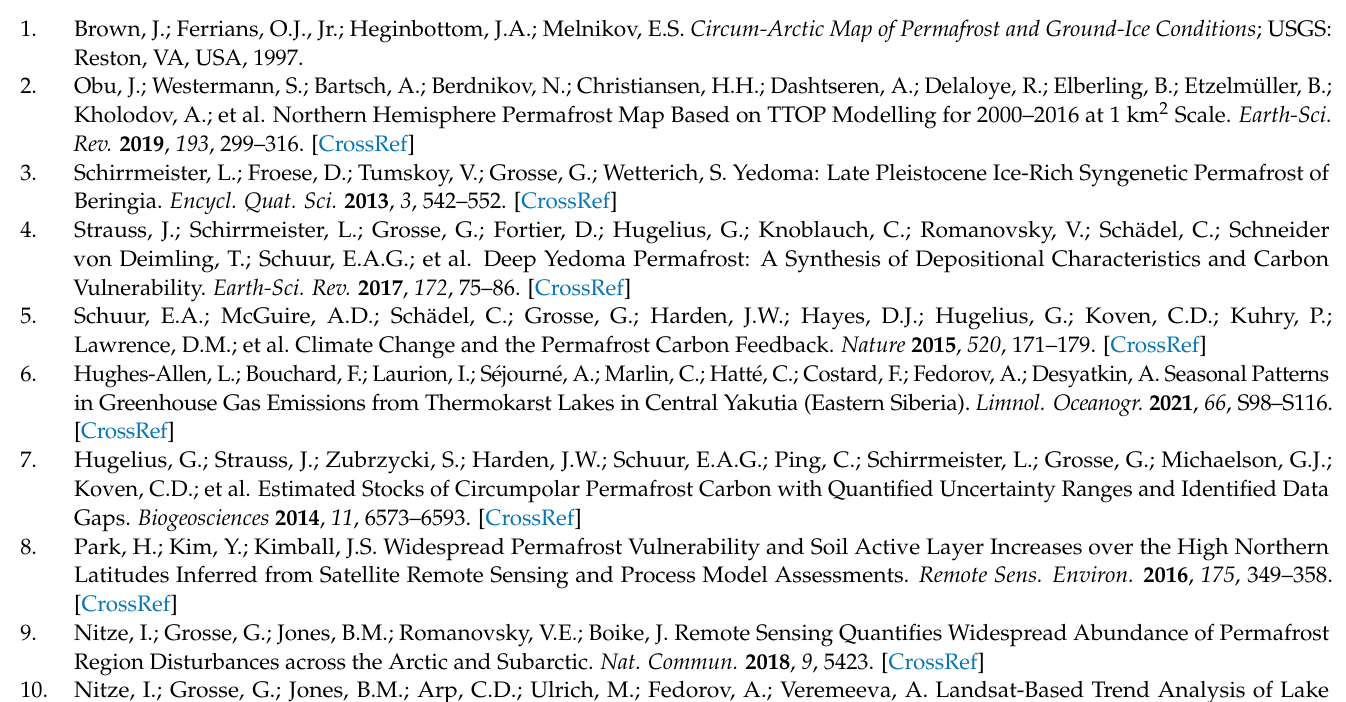
Figure S3: 2007_lakes_south; Figure S4: 2010_lakes_south; Figure S5: 2011_lakes_south; Figure S6: 2012_lakes_south; Figure S7: 2019_lakes_South; Figure S8: 1967_lakes_center; Figure S9: 1980_lakes_center; Figure S10: 2010_lakes_center; Figure S11: 2011_lakes_center; Figure S12: 2012_lakes_center; Figure